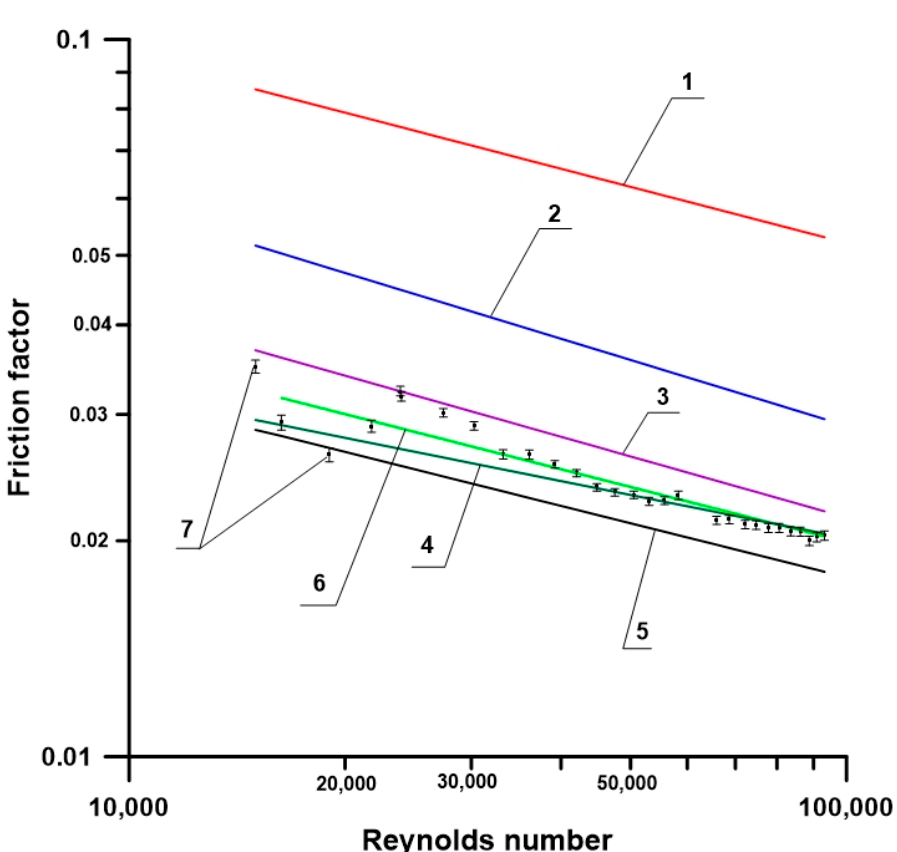
Figure 10. Comparison of the experimental data with the correlations defining the friction factor in rifled tubes with internal helical ribs and smooth tubes; 1—Equation (13); 2—Equation (11); 3— Equation (14);. 4—Equation (9); 5—Equation (2); 6—the proposed equation (Equation (20)); 7—experimental data.